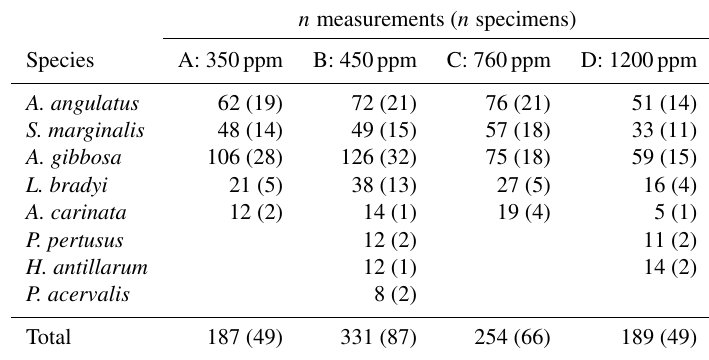
Table 2. Total number of LA-ICP-MS measurements per species, per treatment (A–D).